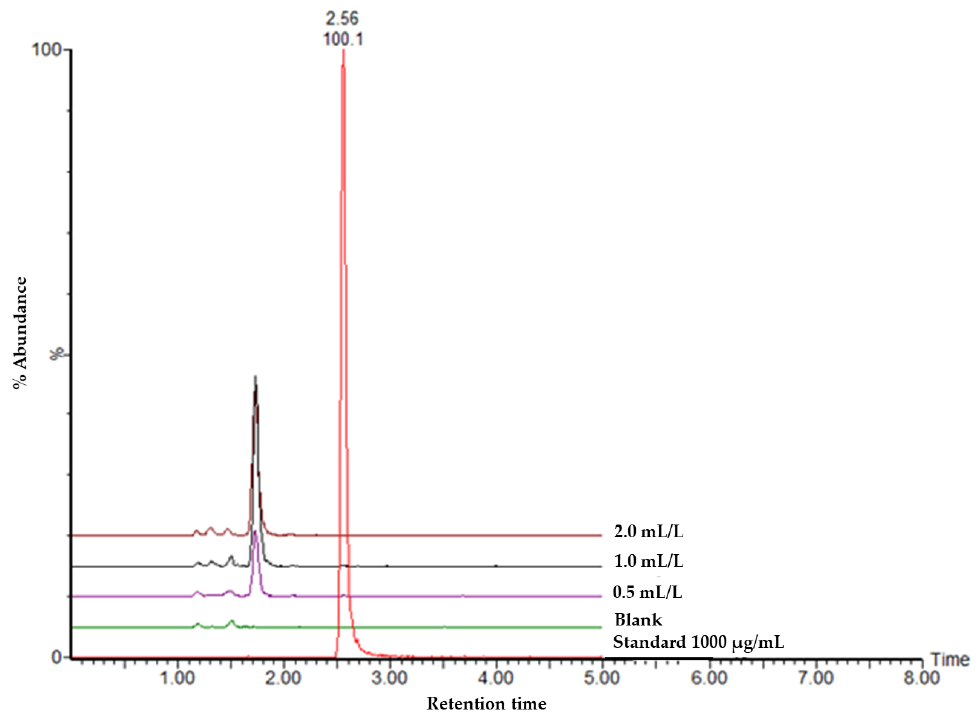
Figure 5. Chromatograms of fruit samples 24 h after four applications of HYM.